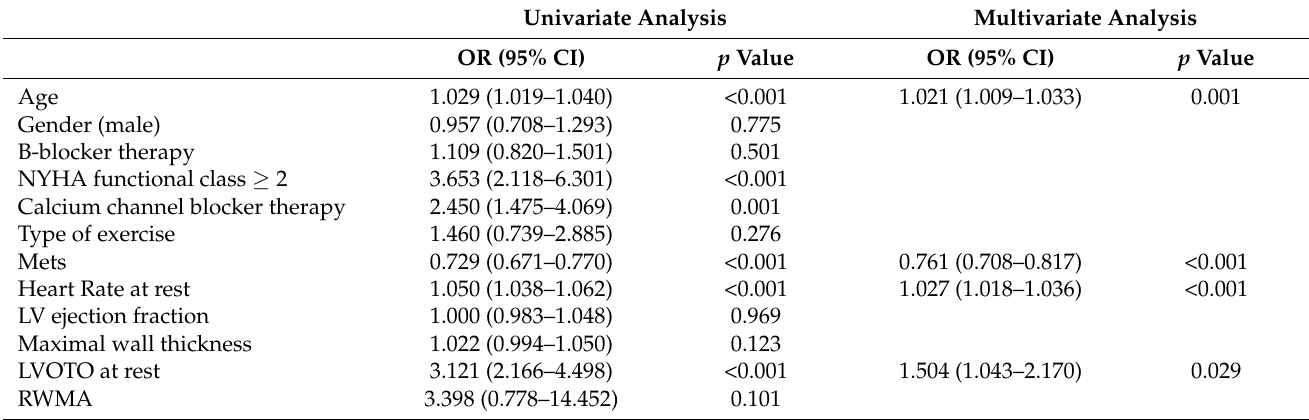
Table 3. Univariate and multivariate predictors of lowest quartile of abnormal heart rate reserve (HRR). Univariate Analysis Multivariate